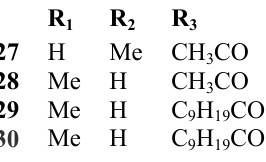
Figure 2. Chemical structures of the other compounds detected by GC-MS in Dorstenia arifolia